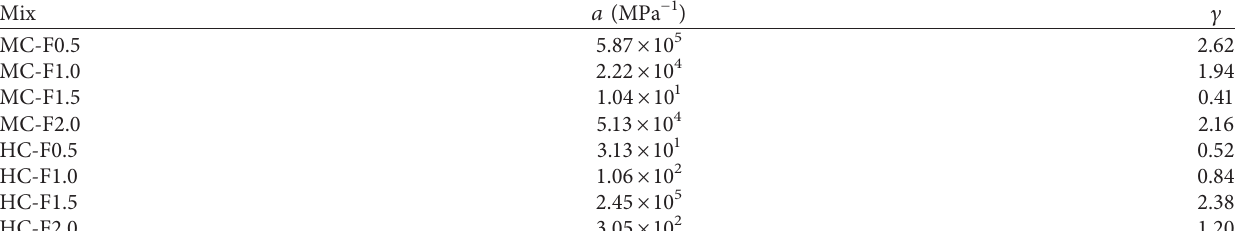
Table 5: Material parameters in the damage